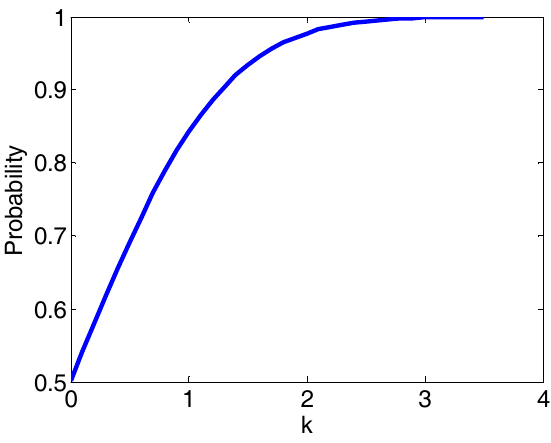
Figure 1. The probability of P ( r ai − k σ i < r mi < r ai + k σ i ) with different k.